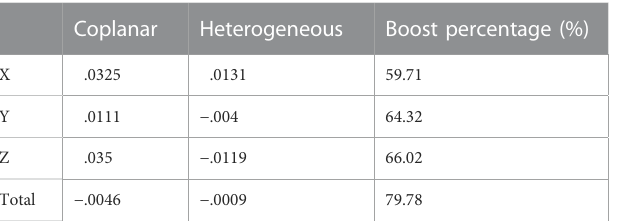
TABLE 2 Comparison of calculation results of coplanar and heterogeneous formulas. Coplanar